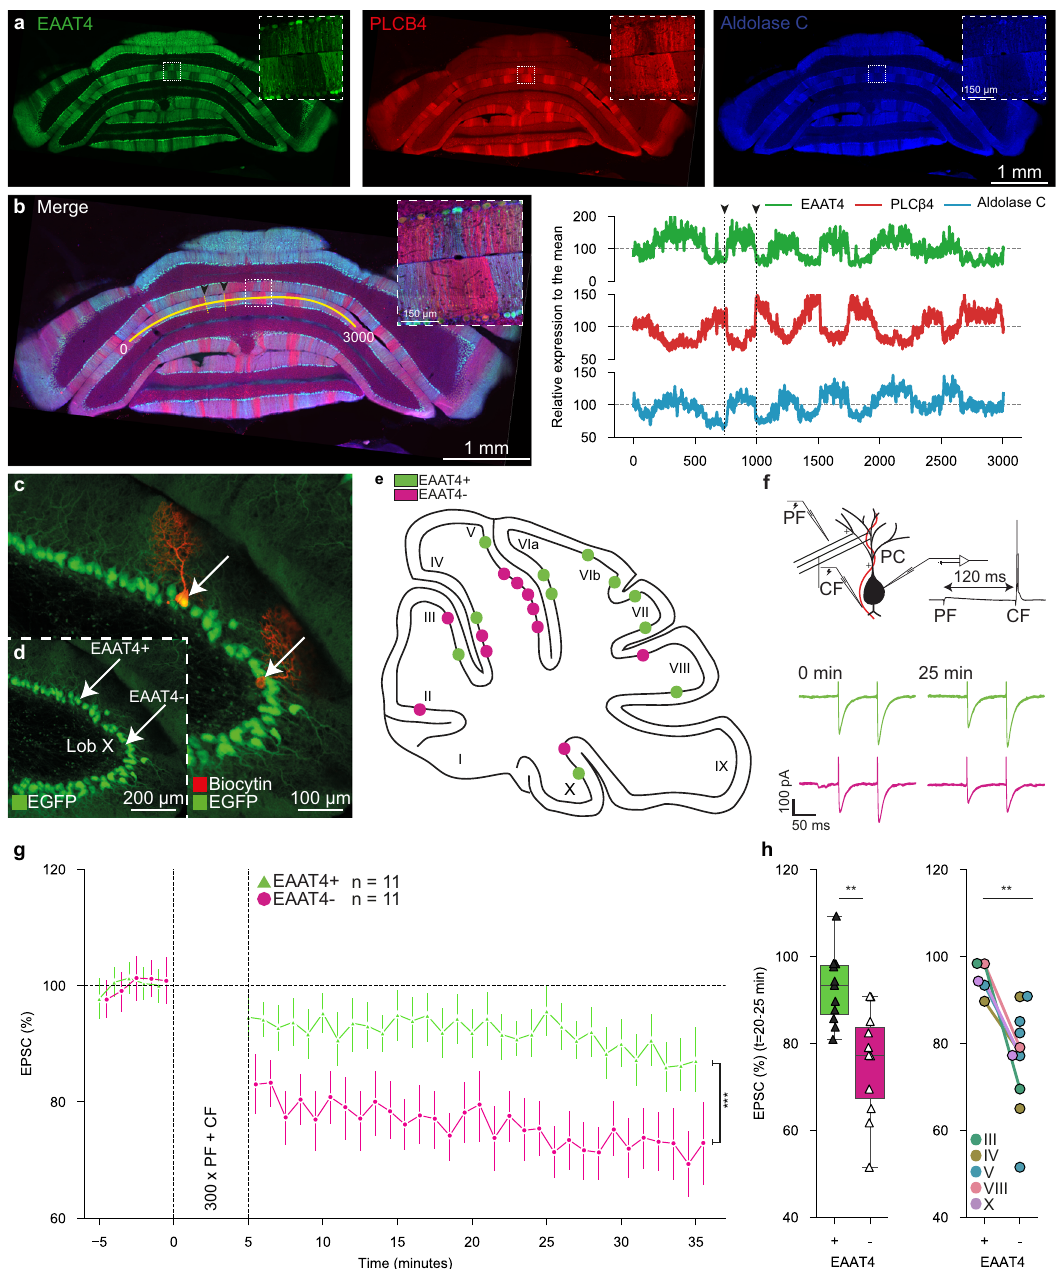
Fig. 1 EAAT4-/PLCB4 + PCs exhibit stronger LTD than EAAT4 + /PLCB4- PCs. a Coronal cerebellar sections show the expression patterns of EAAT4 (left), PLCB4 (middle) and AldoC (right). Insets, magni fi cation of lobule VII/VIII. EAAT4 expression is complementary to PLCB4 expression and follows AldoC expression. b Merge of images in a (left), used in the quanti fi cation of expression (right). Normalized expression of EAAT4, PLCB4, and AldoC (right). Black dotted line represents the yellow dotted line in the left panel. c , d Example confocal image of a sagittal slice with two patched and labelled PCs (arrows) in lobule X, one EAAT4 + and one EAAT4-. e Map of all cells included in LTD analysis, sorted by their EAAT4 expression. In total, 11 EAAT4 + cells and 11 EAAT4- cells are mapped. f Schematic representation of the LTD induction protocol (top), and example traces of EPSCs before and 25 minutes after LTD induction (bottom). g Time-course of the EPSC amplitude over time. LTD induction occurred between 0 and 5 minutes. LTD induction was signi fi cantly stronger in EAAT4- PCs. EPSC amplitude is normalized to the mean value before LTD induction. Error bars represent 95% con fi dence interval (CI). h Normalized EPSC size 25 minutes after LTD induction (left). When comparing only sets of PCs within the same lobule, LTD was still stronger in EAAT4- PCs (right) (EAAT4 + n = 5, EAAT4- n = 10). Bars and boxes represent a 25 th percentile. *** = p < 0.001, ** = p < 0.01. Independent samples t-test was used for data presented in 1 g,h (left). Mann-Whitney U-test was used for data presented in panel 1 h (right) (Suppl. Table Methods sagittal and coronal slices. Adult animals aged >P40 were used in all in vitro electro- Animals . In the present study, we utilized EAAT4 as a marker for PC subpopulations. physiology experiments (mean age 132 days). Both male and female mice were used. All animal experiments were performed in accordance with the guidelines of the Dutch The expression of EAAT4 is correlated with that of Aldolase C (Fig. 1; see also ref. 28 ). Ethical Committee for animal experiments, and in accordance with the Animal Welfare In order to identify EAAT4 expression in vitro, we utilized an EAAT4-eGFP-reporter Board of the Erasmus MC, in line with Dutch and EU legislation. mouseline. This allowed for the identi fi cation of EAAT4 + and EAAT4- PCs in both